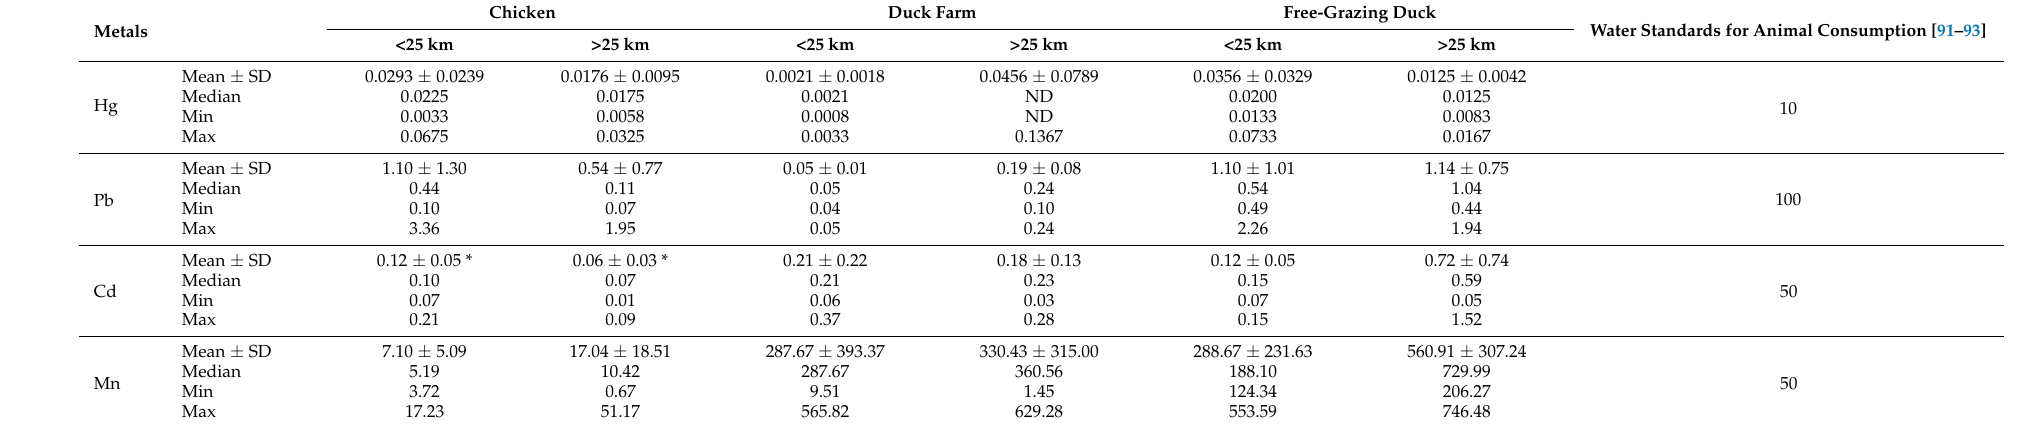
Table 5. Mean ± SD, the median, minimum, and maximum values of Hg, Pb, Cd, and Mn concentrations in drinking water ( µ L L − 1